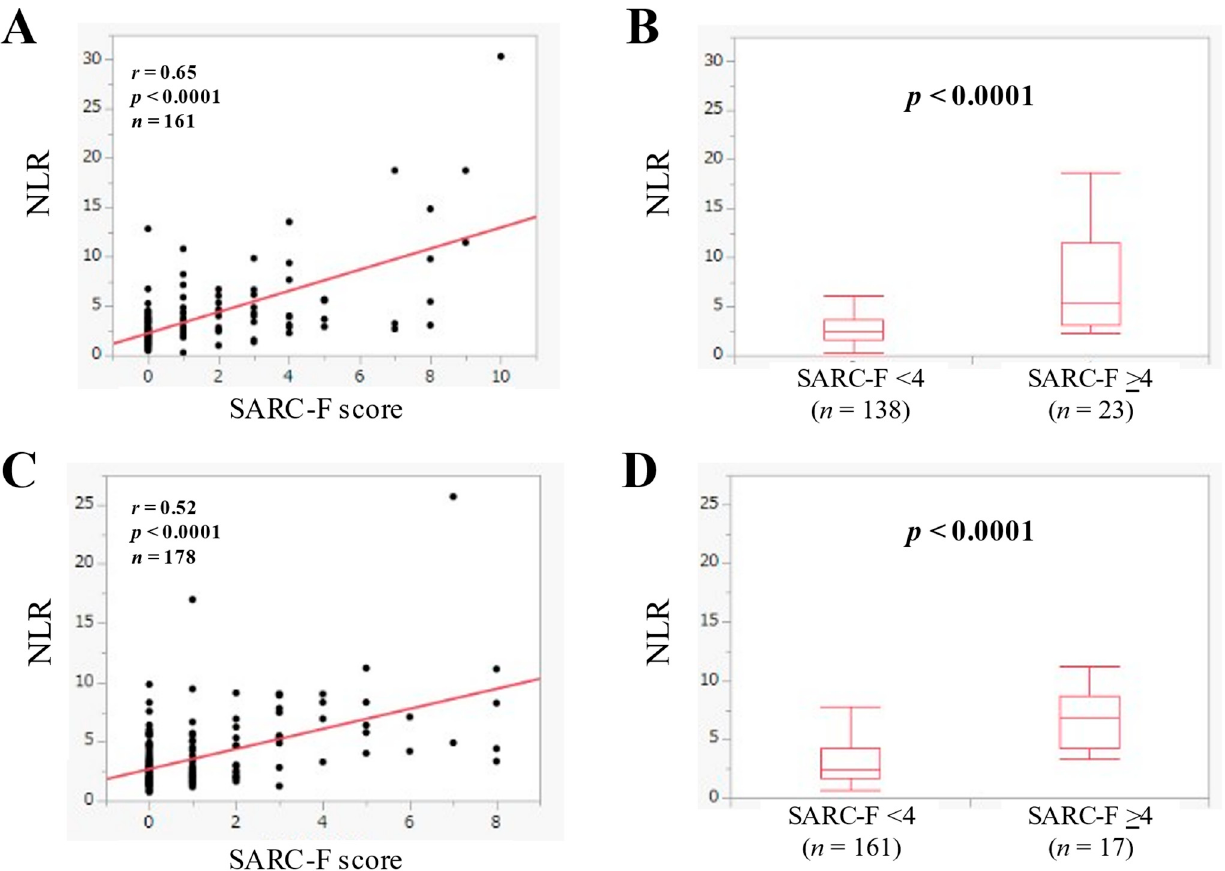
Figure 3. ( A ) The relevance in the NLR and the SARC-F score in U-G-D cases ( n = 161). ( B ) Comparison of NLR between SARC-F <4 ( n = 138) and ≥ 4 ( n = 23) in U-G-D cases. ( C ) The relevance in the NLR and the SARC-F score in L-G-D cases ( n = 178). ( D ) Comparison of NLR between SARC-F <4 ( n = 161) and ≥ 4 ( n = 17) in L-G-D